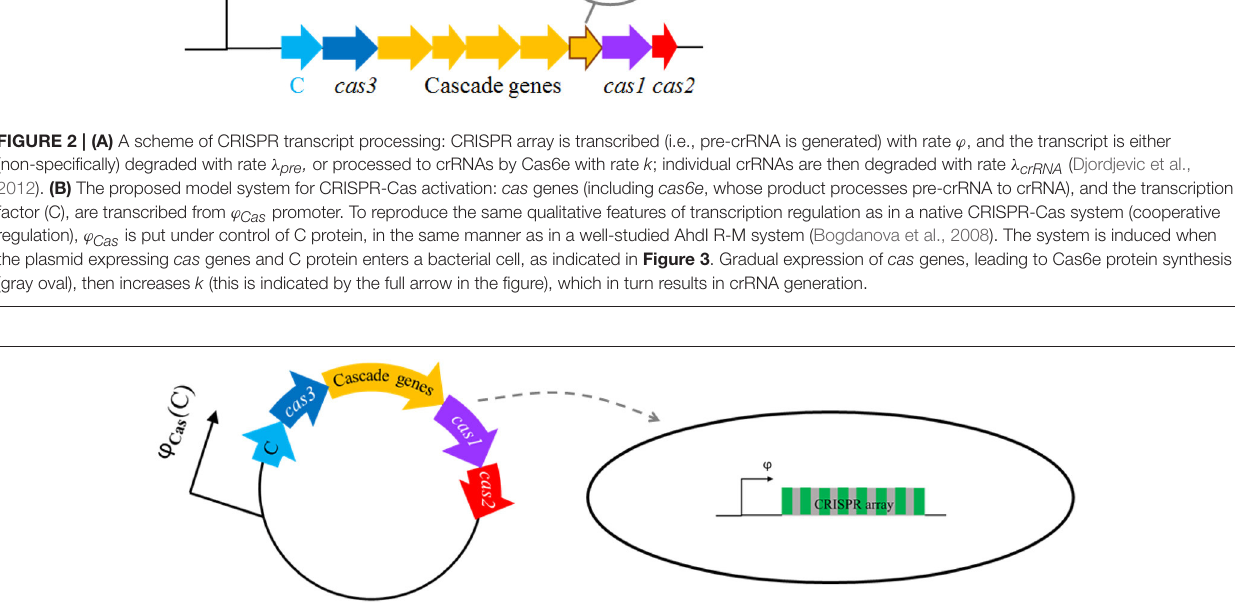
FIGURE 3 | A scheme of the basic setup: pre-crRNA is transcribed in a cell from CRISPR array with rate ϕ . Transcription of cas genes occurs from a plasmid, which enters the cell, inducing crRNA generation. A transcription regulator (C) is transcribed together with cas genes, regulating transcription of the ϕ Cas promoter in a same qualitative manner as exhibited in native CRISPR-Cas system. To achieve this, C protein controls transcription of ϕ Cas promoter in the same way as in a well-studied R-M system. This leads to a gradual synthesis of Cas6e and C protein, leading to system activation, as schematically shown in Figure 2B